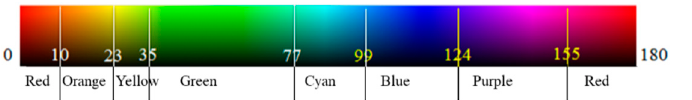
Figure 2. The distribution of H values corresponding to different color tones, regardless of the S and V.